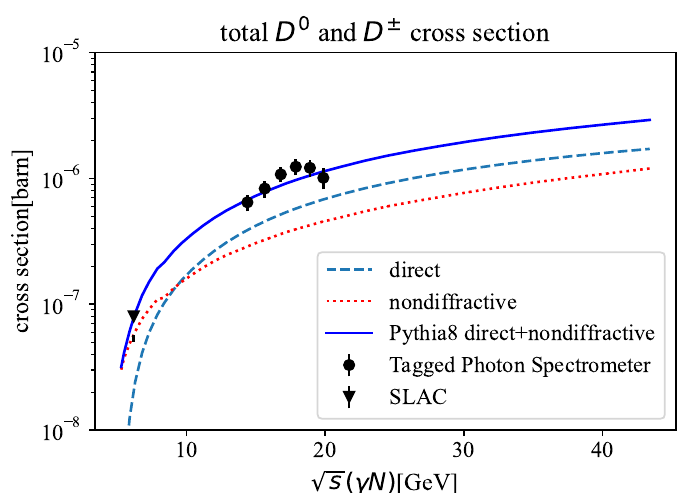
Figure 9 . The photoproduction cross section of D mesons ( D ± , D 0 and D 0 ), and the PYTHIA8 prediction. The dotted and long dashed lines correspond to non-diffractive and direct production cross section of charm quark. The solid line is the total charm meson production cross section. They are consistent with the measured cross section of Tagged Photon Spectrometer (circle) [23] and SLAC (triangle)